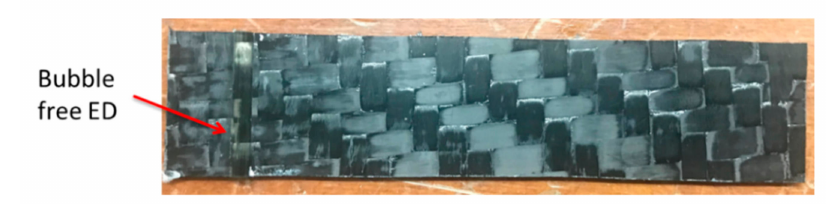
Figure 4. Manufactured Energy Director (ED) laminate with optimized